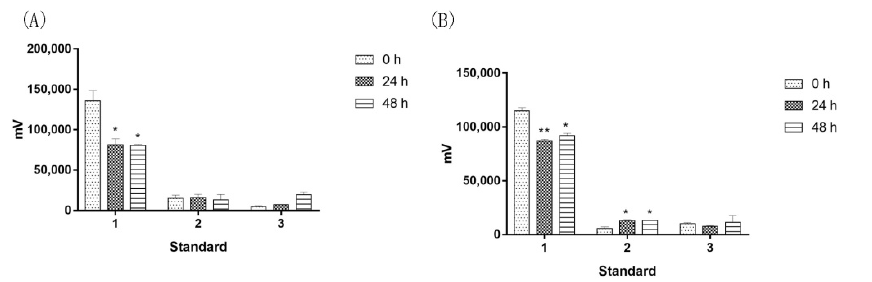
Figure 4. Effect of saprophytic Bacilli on major effective components of Agarwood ( A ): Bs-2 was separately put in a test tube with liquid LB medium and different major standards (Standard 1: agarotetrol; Standard 2: 6,7-dimethoxy-2-(2-phenylethyl)chromone; Standard 3: 2-(2-phenylethyl)chromone), and then the mixture was incubated. Samples were taken at 0 h, 24 h and 48 h, and then filtered for HPLC analysis. ( B ): Bs-4 was separately put in a test tube with liquid LB medium and different major standards (Standard 1: agarotetrol; Standard 2: 6,7-dimethoxy-2-(2-phenylethyl)chromone;